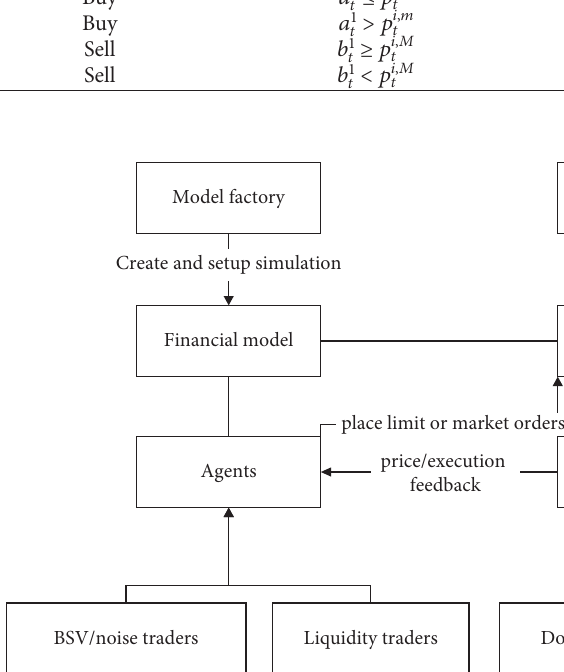
Table 1: Summary of submission rules of agent i , 0 ≤ X ≤ 1, is drawn from a uniform distribution.